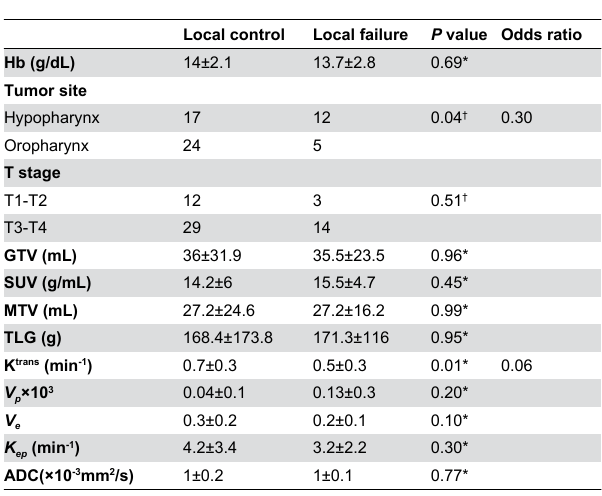
Figure 6. Scatterplots of the incidence of local failure with respect to the relationship between K trans and SUV area of interest was divided into subsections (lines) using a cut-off of 0.45 min -1 for K trans and a cut-off of 13.76 g/mL for SUV doi: